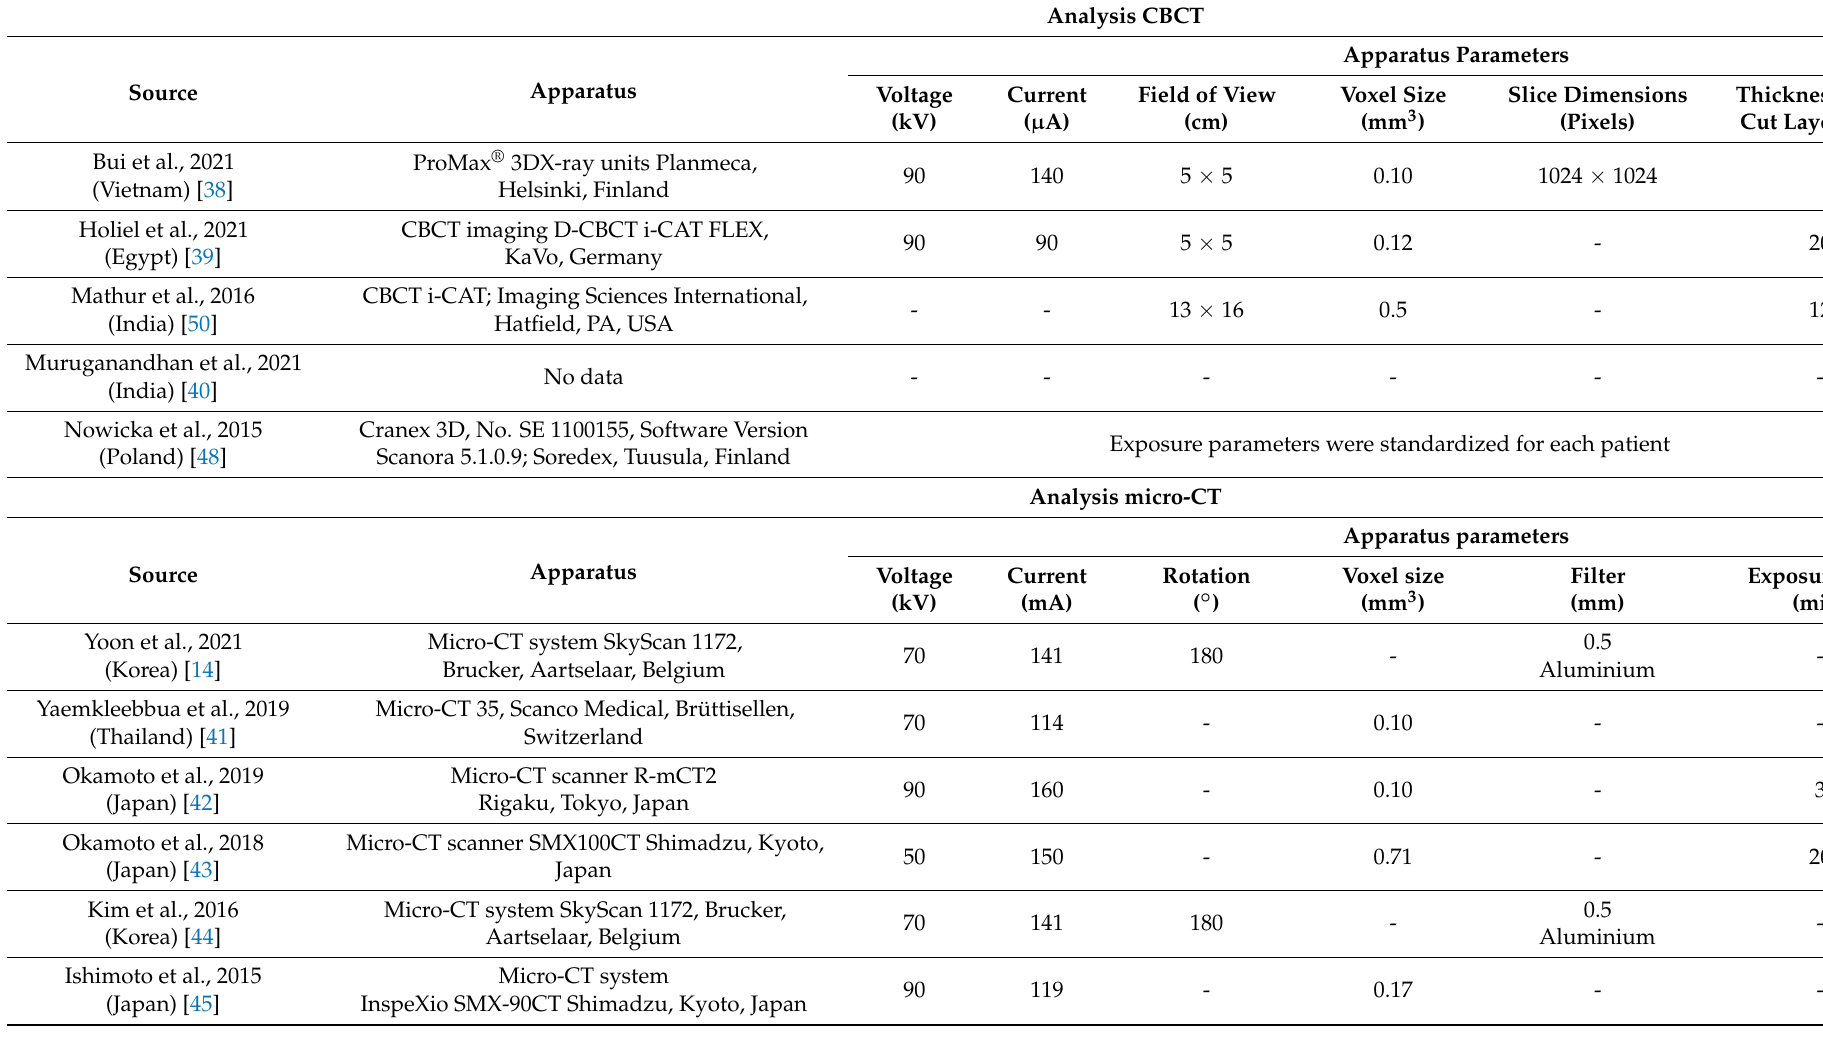
Table 7. The most important parameters of the CBCT and micro-CT